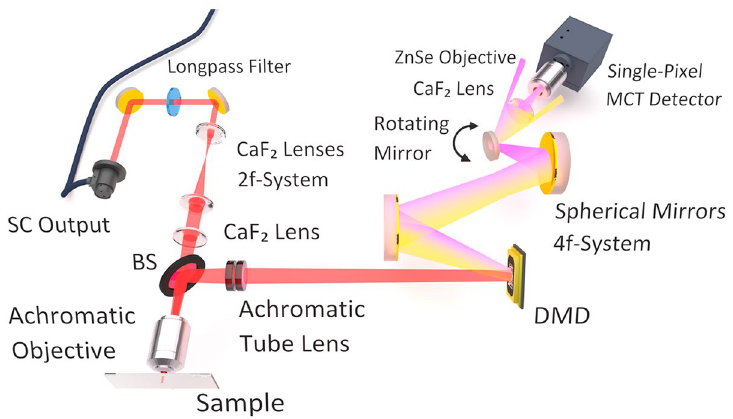
Figure 1. Schematic illustration of the experimental setup. The emission of an MIR SCL passes two uncoated gold mirrors and a 2.4 µ m longpass filter before it illuminates the sample by means of a set of three CaF 2 lenses and an achromatic ZnSe objective. A pellicle beamsplitter (BS) redirects the radiation to an achromatic tube lens, which images the sample onto an MIR-modified DMD. The DMD sequentially masks the projected image and angularly disperses its constituting spectral components due to diffraction. A 4f-system of spherical gold mirrors replicates the DMD field and unifies the spectral images on a rotating gold mirror which selects the spectral band that is projected onto a single-pixel MCT detector by means of a CaF 2 lens and a ZnSe